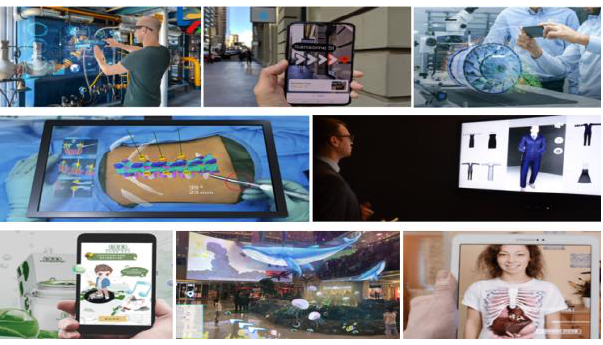
Fig. 5. AR Application Examples